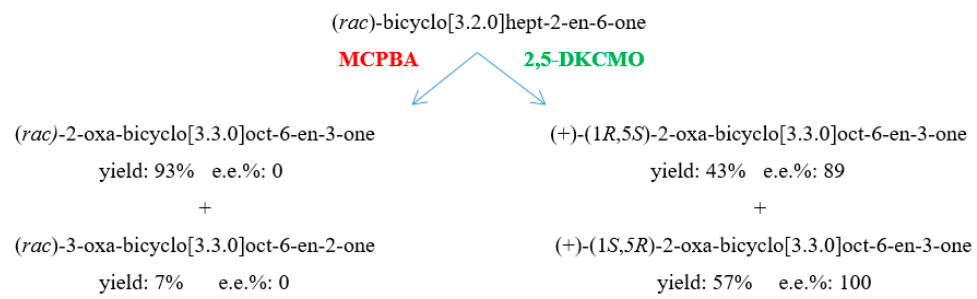
Figure 11. Contrasting outcomes of the lactonization of ( rac )-bicyclo[3.2.0]hept-2-en-6-one by chemical oxidation (metachlorperbenzoic acid, MCPBA) and biotransformation (2,5-DKCMO); e.e.% = enantiomeric excess.